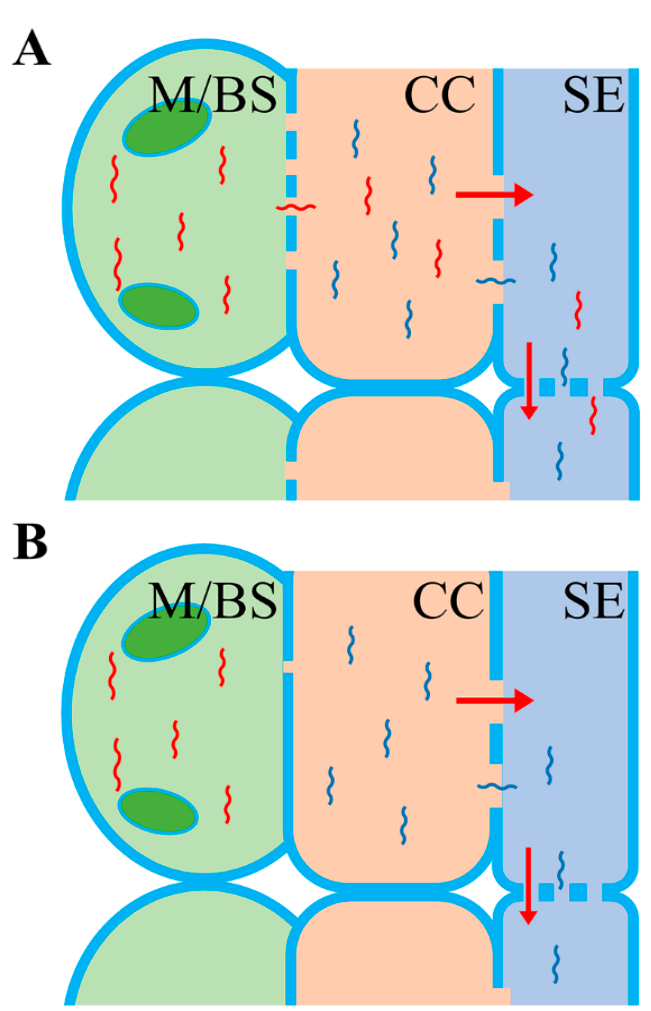
Figure 1. Postulated model related to the origin of mobile mRNAs in woody and herbaceous plants. ( A ) The abundant plasmodesmata between the M / BS and CC in woody species allow the movement of mRNAs transcribed in the M / BS cells to the CC–SE. mRNAs transcribed in the CC also have the potential to move to the SE for long-distance transport. ( B ) The very rare and narrow plasmodesmata between the M / BS and CC in the herbaceous species restrict the movement of mRNAs transcribed in the M / BS cells to the CC. Only mRNAs transcribed in the CC have the potential to move to the SE for long-distance transport. M / BS: mesophyll cells or bundle sheath cells; CC: companion cell; SE: sieve element.